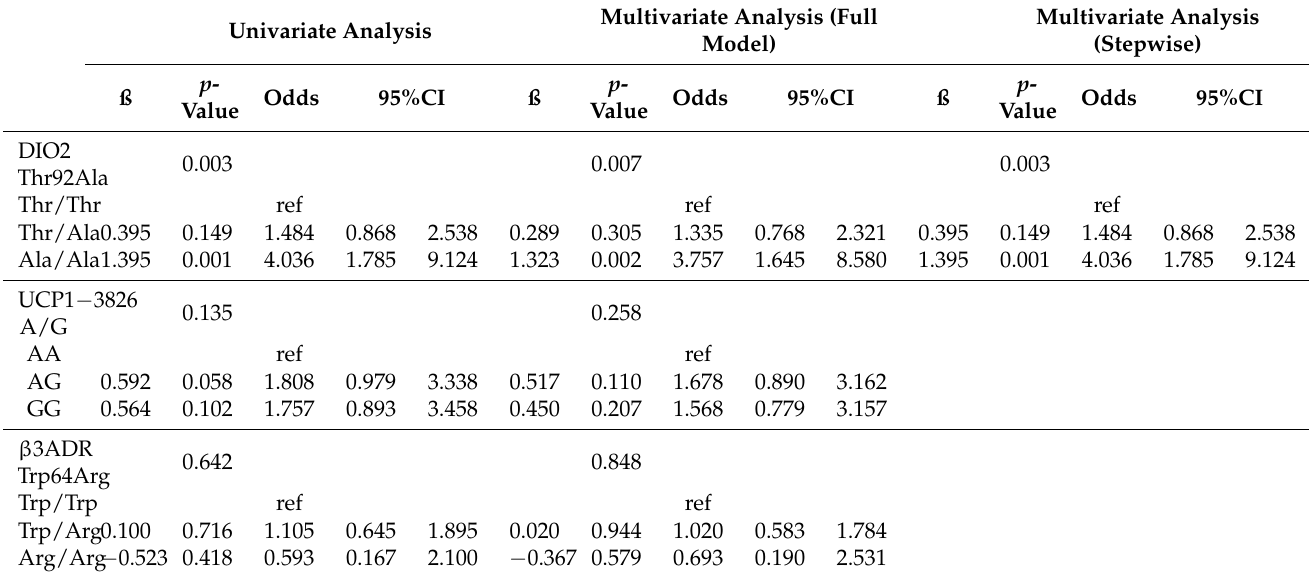
Table 3. Uni- and multivariate analyses with respect to obesity classified based on the percentage of weight.